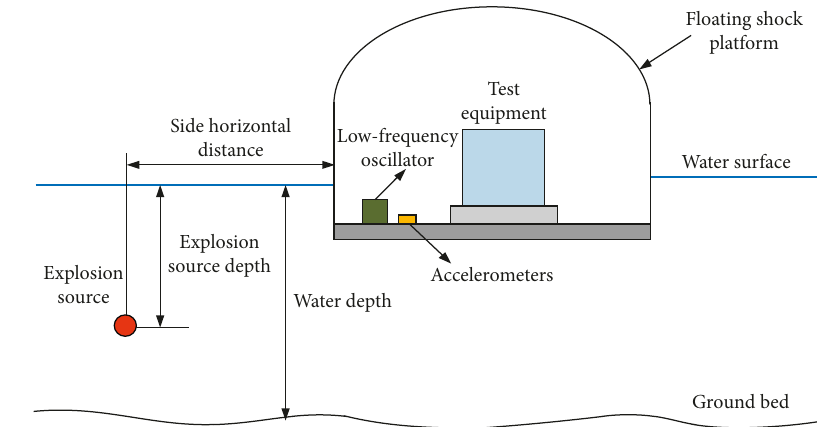
Figure 1: Schematic diagram of the floating shock platform. Table 1: Test conditions of the floating shock platform.